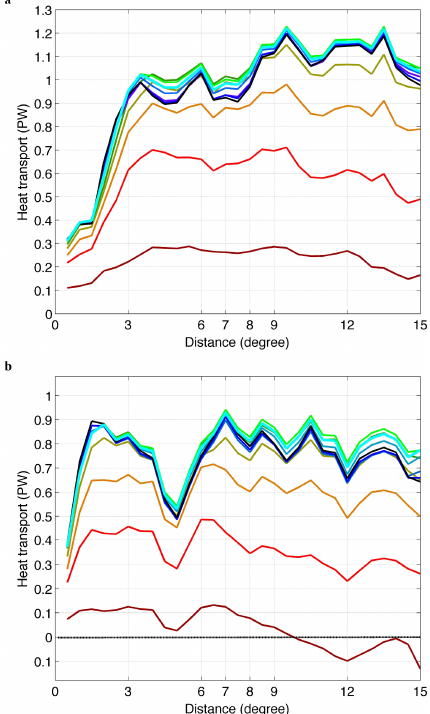
Figure 5. The impacts of domain size on global annual heat trans- fer from the ocean to the atmosphere by TCs for (a) TS/TDs and (b) hurricanes. The colors are the same as those in Fig. 4.